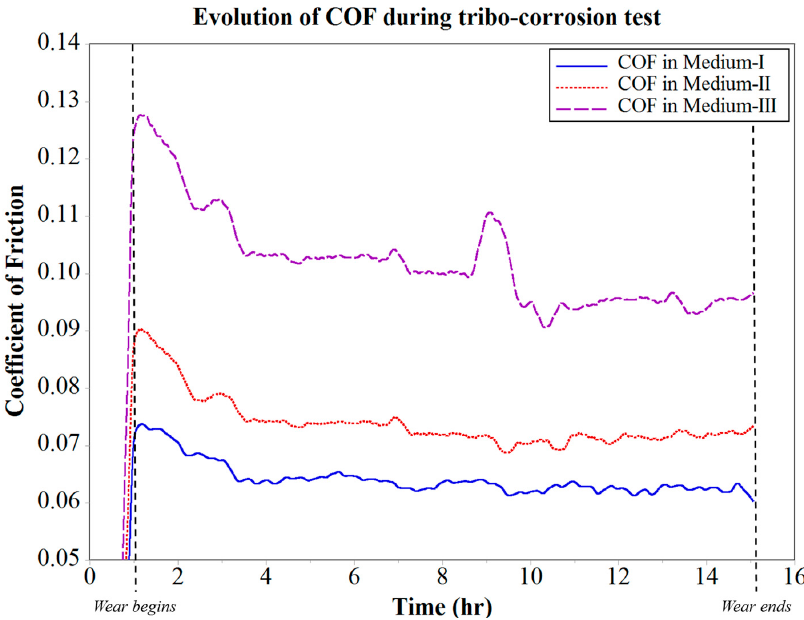
Figure 7. Evolution of COF during tribo-corrosion testing